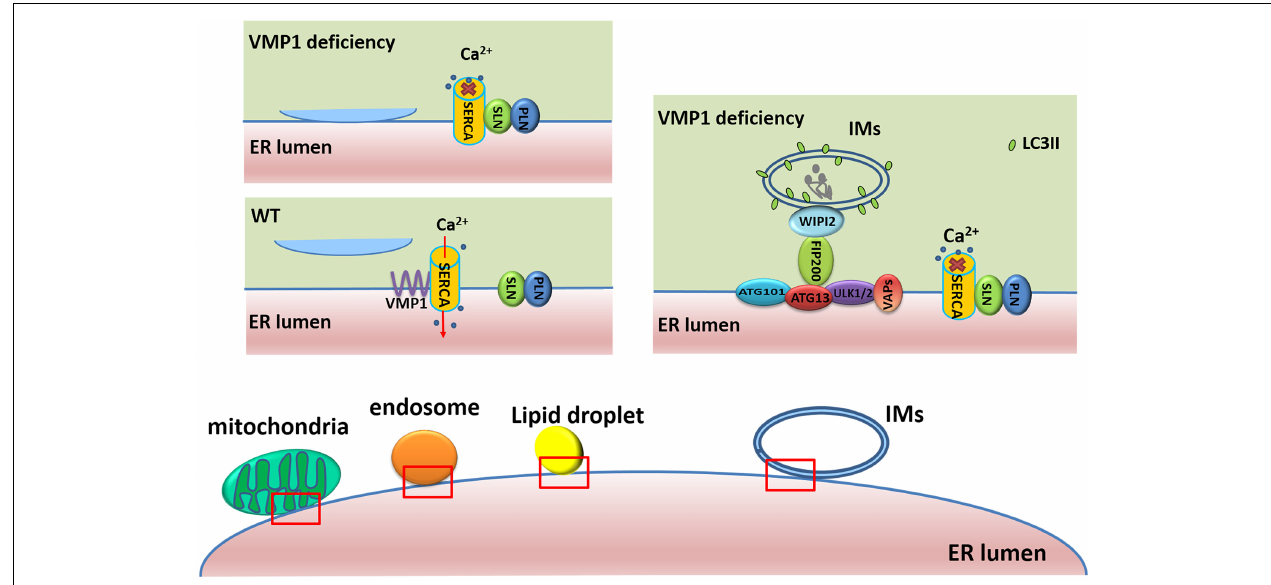
FIGURE 2 | Roles of VMP1 in ER–membrane contacts. In WT cells, VMP1 competes with the inhibitory complex of PLN/SLN for interaction with SERCA to regulate the contacts of membrane structures (including mitochondria, endosome, and LDs) with ER. In VMP1-deficient cells, the interaction of SERCA with PLN/SLN leads to higher cytosolic Ca 2 + levels and failure of the detachment of ER–membrane structure contacts. WIPI2 tethers IMs to the ER through interaction with ULK1/FIP200, and these interactions are reinforced by VMP1 depletion.